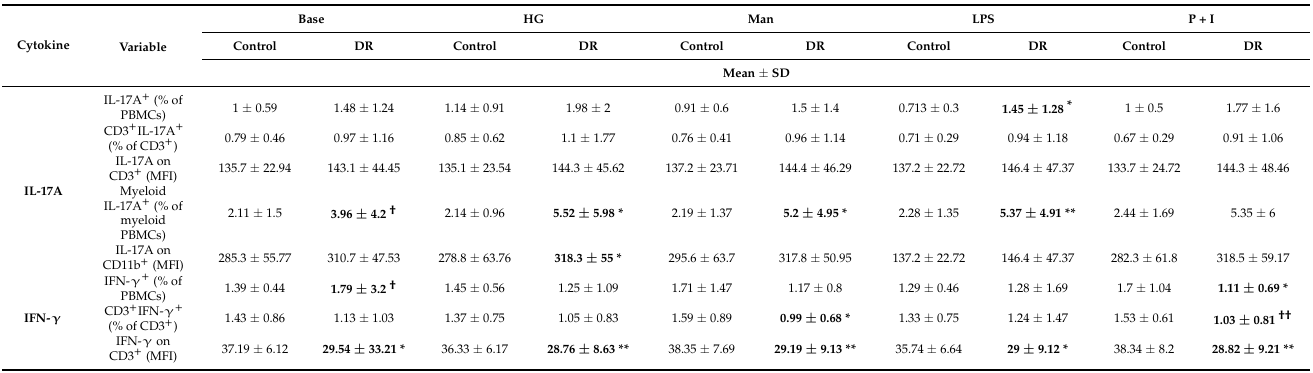
Table 3. Cytokine expression of PBMCs from DR patients and healthy controls in different culture conditions.